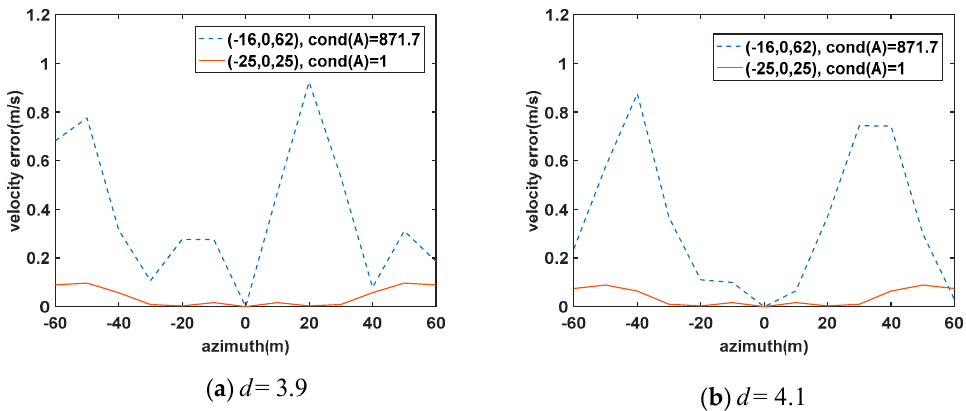
Figure 4. The influence on the velocity caused by the estimated baseline d